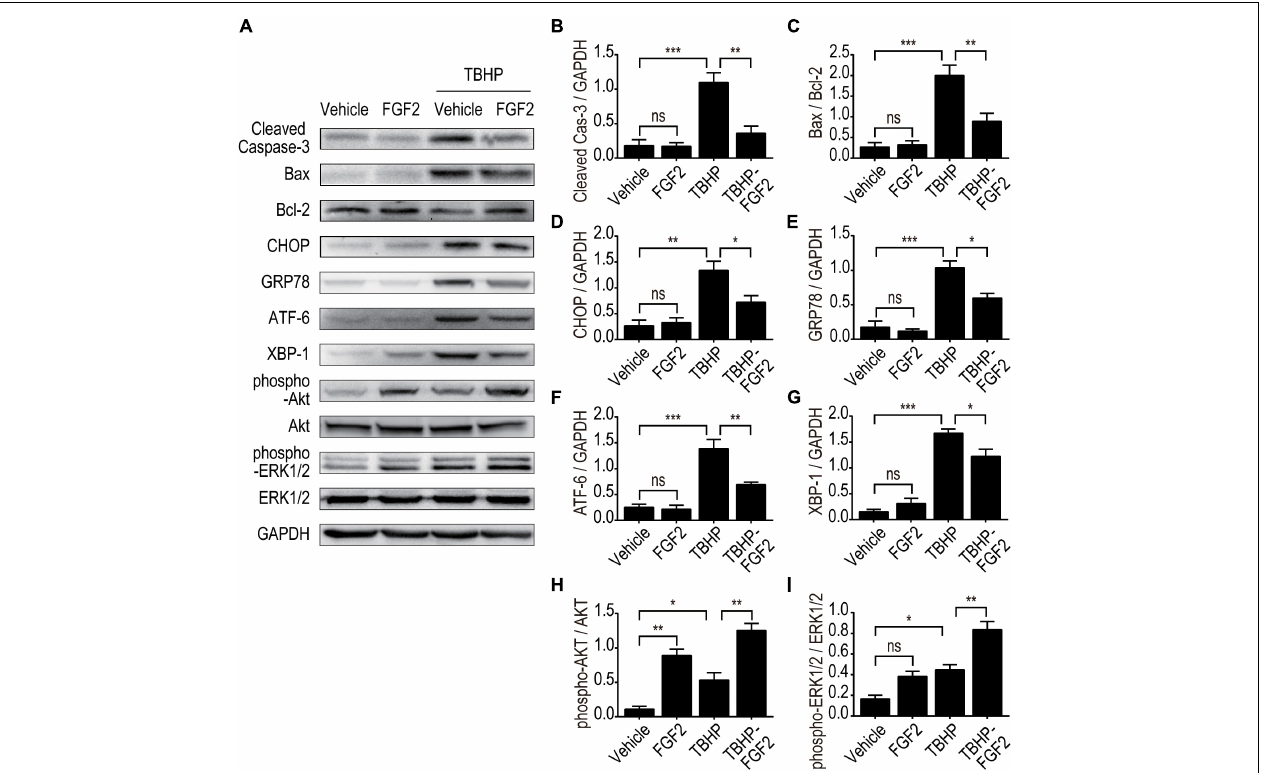
FIGURE 6 | The effect of FGF2 on the inhibition of apoptosis and ER stress and the activation of the Akt and ERK1/2 signaling pathway was detected in vitro . (A) The expression of pro-apoptotic proteins, the expression of ER stress-relevant proteins, and the phosphorylation of Akt and ERK1/2 were detected by Western blotting. Images are representative of five animals in each group. (B–I) The histograms show the normalized optical density analysis. FGF2 significantly decreased the expression of cleaved Caspase-3, Bax, CHOP, GRP78, ATF-6, and XBP-1 in NRK-52E treated with TBHP. The phosphorylation of Akt and ERK1/2 was increased in the TBHP-FGF2 group compared with the TBHP group. Representative data of five individual samples in each group. * P < 0.05, ** P < 0.01, *** P < 0.001; ns indicates not statistically significant.